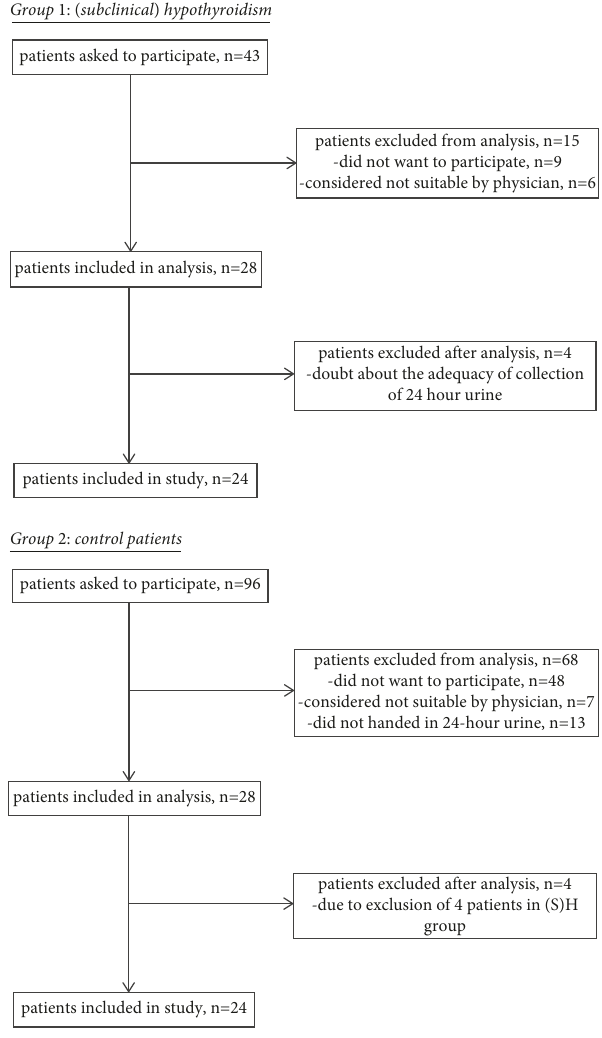
Figure 1: Inclusion